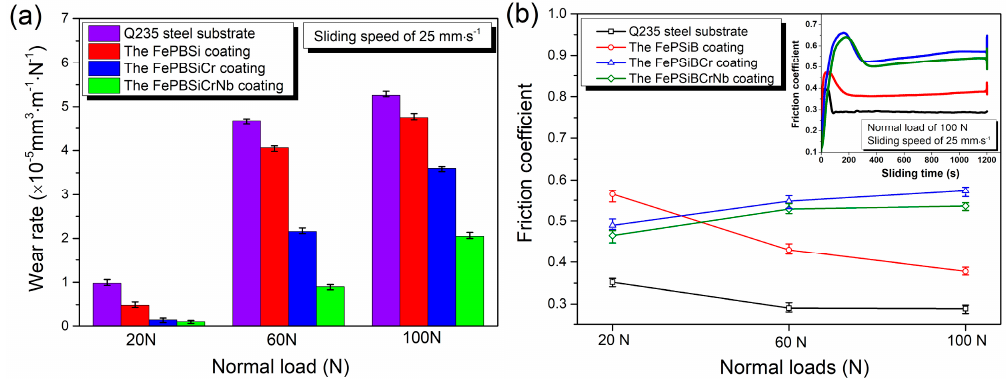
Figure 2. ( a ) Wear rates and ( b ) friction coefficients of the tested samples with different loads ( v = 25 mm·s − 1 ).